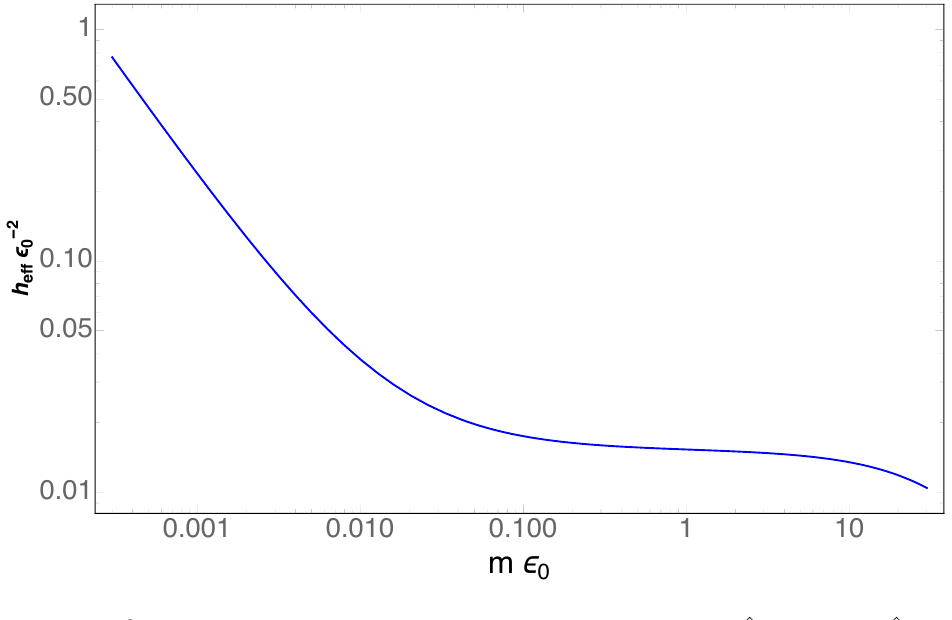
Figure 3 . h e(cid:11) =(cid:15) 2 as a function of m(cid:15) 0 . The coe(cid:14)cients are taken to be ^ (cid:21) 0 appropriate for a spherical surface charge distribution discussed in appendix A.1. The dispersion relation for k is given in